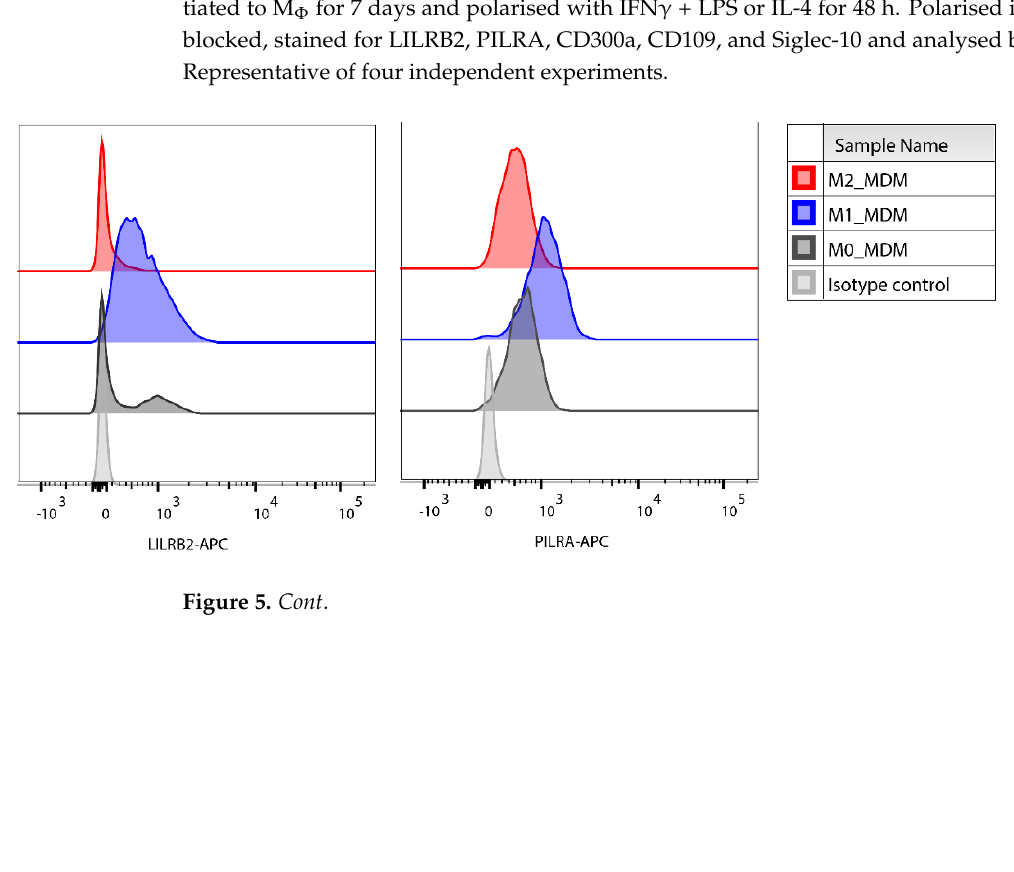
Figure 5. Validation of expression of novel polarisation markers in monocyte − derived macrophages (MDM). Peripheral blood monocyte − derived monocytes were differentiated to M ɸ for 7 days and p olarised with IFNγ + LPS or IL − 4 for 48 h. Polarised MDM were stained for LILRB2, PILRA, CD300a, CD109, and Siglec − 10 and analysed by FACS Canto. Representative of four independent donors. PD1/PD-L1 (CD274) is an immune checkpoint that dampens immune response me- diated by M ɸ [28]. As shown previously [29 –31], stimulation with IFNγ and LPS increased expression of CD274 in iPSDM (Figure 3A,B), which could be a mechanism of feedback inhibition of inflammation in M ɸ . Phagocytosis of pathogens and apoptotic cells is mediated by several receptors such as CD14, CD36, CD44, FCGR1 (CD64), MSR1, CD206, and CD163, all of which were highly expressed in M0 iPSDM (Figures 3A,C and S1). We observed a significant increase in the expression of CD14, FCGR1, and CD44 in M1 iPSDM (Figure 3A,C). As shown previously for MDM [32], the well-characterised marker CD206 was upregulated in iPSDM on stim- ulation with IL-4 (Figure 3A,C). CD300a is an inhibitor of phagocytosis of apoptotic cells in M ɸ [33]. Stimulation with IFNγ and LPS mar kedly reduced expression of CD300a in M1 iPSDM (Figure 3A,C) and this was validated by flow cytometry (Figure 4). We also observed similar changes in CD300a expression in polarized MDM, suggesting that this represents a physiologically important response (Figures 5 and S3). To the best of our knowledge, this is the first demonstration that CD300a is regulated on polarized MF and may have important impli- cations for its phagocytic functions.